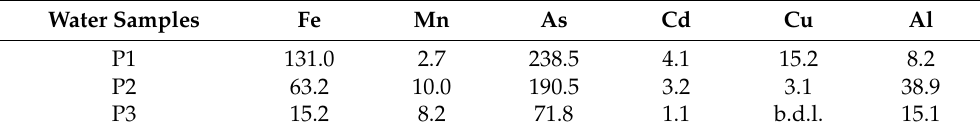
Table 4. Potentially toxic elements and Fe in waters from the area of the Regoufe mine.